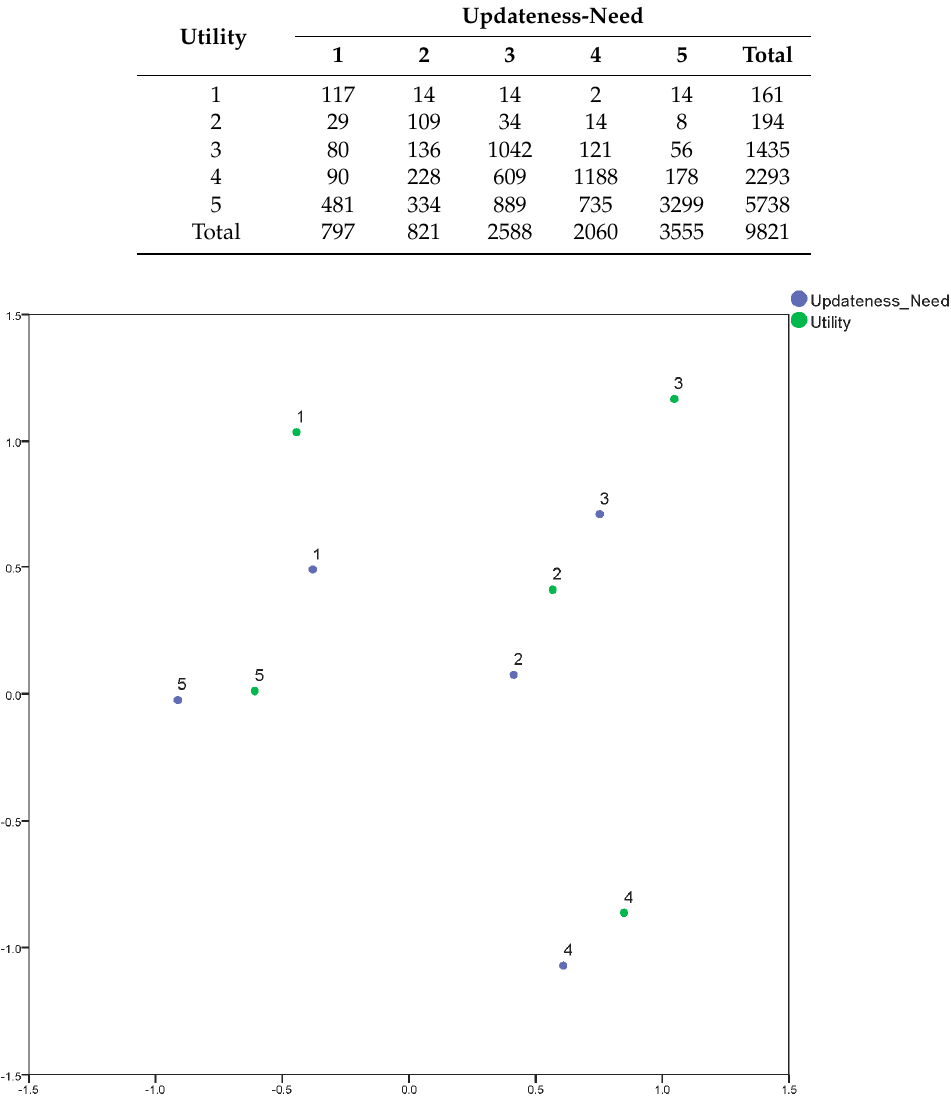
Figure 13. A Pearson Chi squared test between Utility and Need to Update.